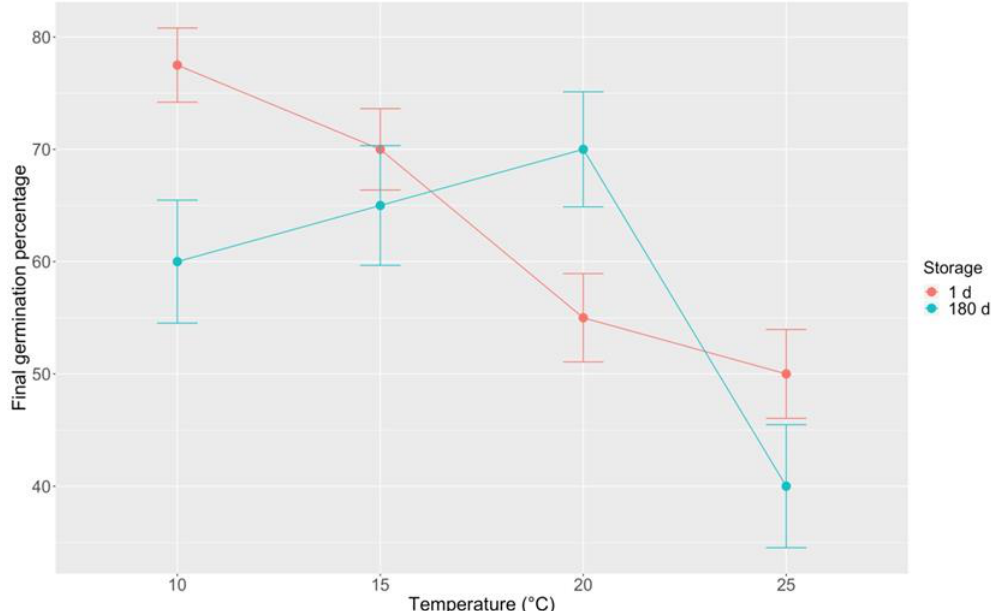
Figure 12. Final germination percentage at di ff erent incubation temperatures (10, 15, 20, 25 ◦ C) for B. basaltica seeds from fresh (1 day) and stored (after 180 days at 5 ± 1 ◦ C) GF pods. GF = green full. Vertical bars represent standard